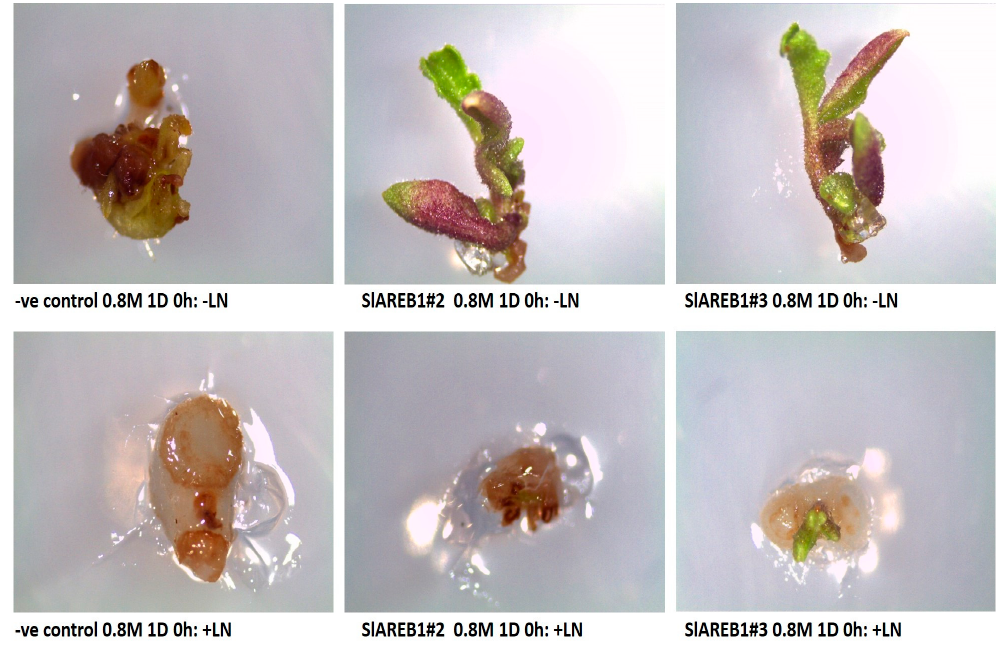
Figure 5. Regrowth of two transgenic lines overexpressing SlAREB1 (SlAREB1#2 and SlAREB1#3) and negative control (-ve control) shoot tips after encapsulation dehydration treatment of 1 day (1 D) incubation in 0.8 M sucrose and 0 h dehydration with (+LN) or without liquid nitrogen ( − LN).